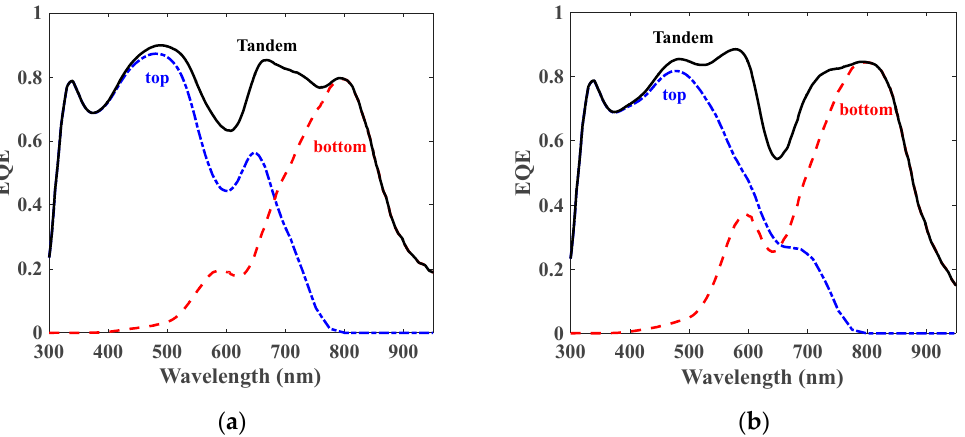
Figure 8. EQE characteristics of sub-cells and tandem cells based on ( a ) optical simulation and ( b ) coupled opto-electrical simulations.